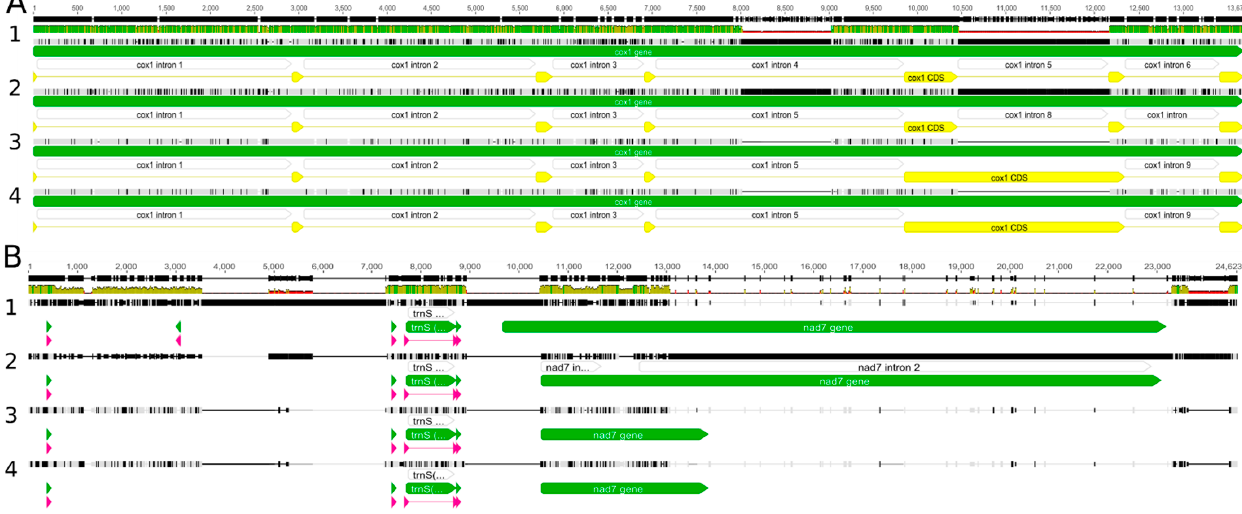
Figure 3. The main sources of mitogenome length variation among Nowellia and its close relatives: 1— Calypogeia integristipula , 2— Nowellia curvifolia , 3— Scapania ornithopodioides , 4— Scapania ampliata . ( A )—intron reductions in cox 1 gene; ( B )—deletion in region between nad 3 and rpl